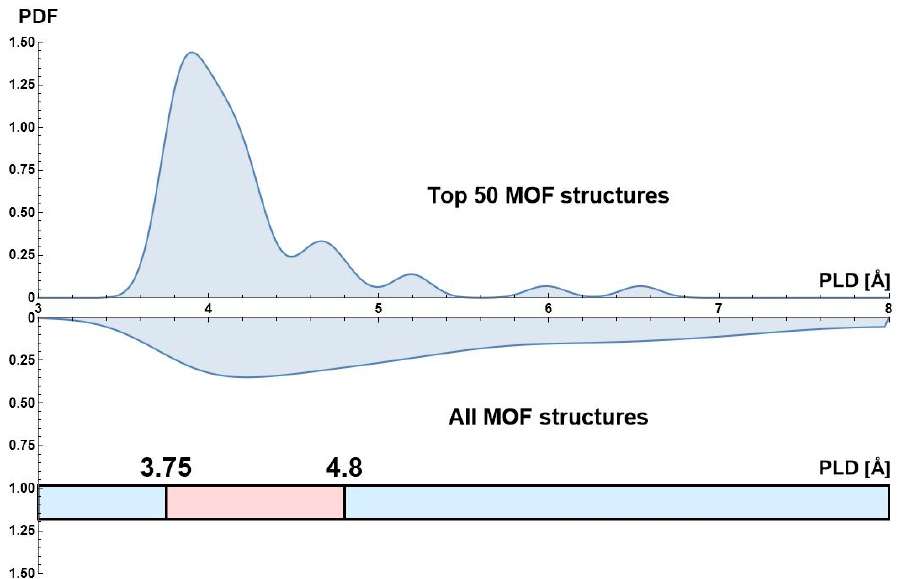
Figure 3. Comparison of the smoothed probability density distribution (PDF) of pore limiting diameter (PLD) for the best 50 MOFs and for all MOFs considered in this study for the VSA separation process. At the bottom of the figure is the PLD range that comprises over 90% of the Top 50 MOFs database.